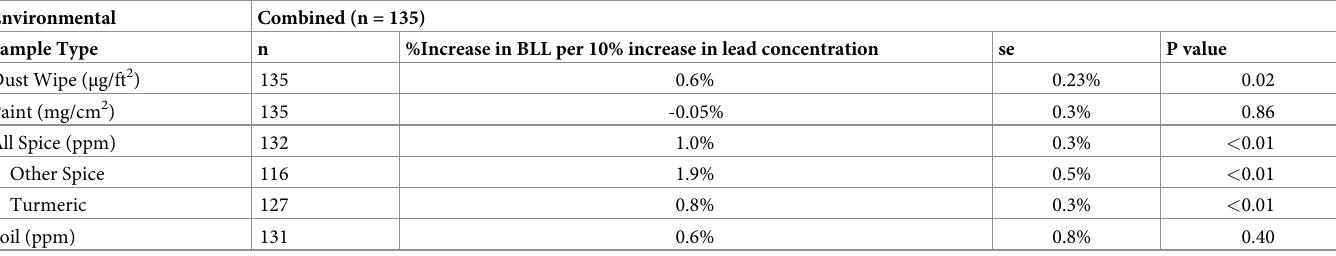
Table 7. Percent increase in BLL for every 10% increase in environmental lead levels in household samples for all children. Patna, Bihar February 2020.